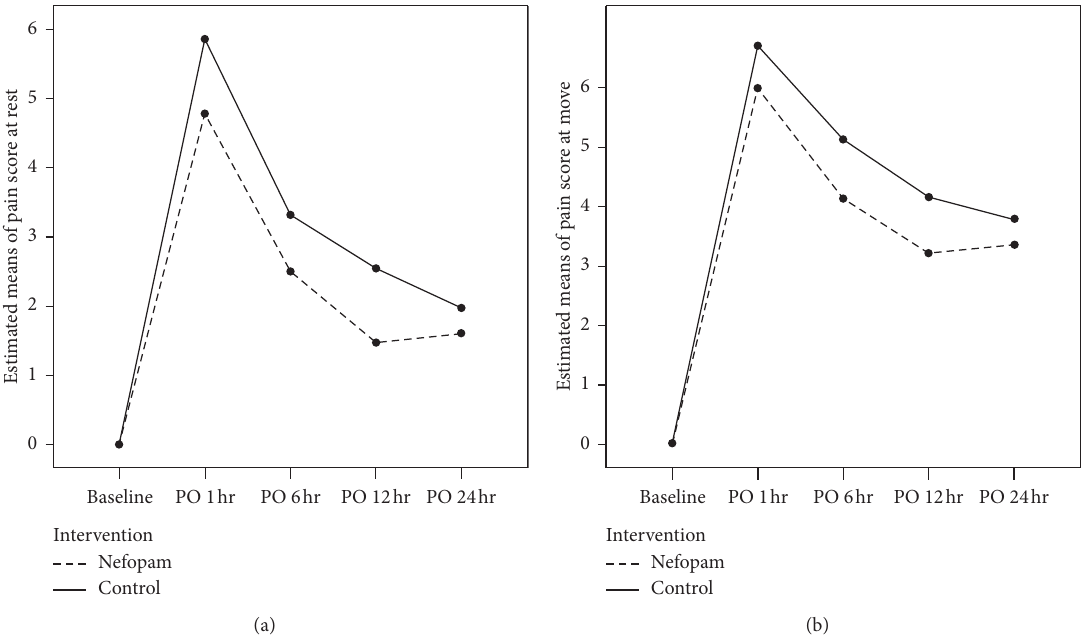
Figure 2: Estimated means of pain score analyzed by mixed-effects regression between nefopam and control at various time points. (a) At rest: no effect of intervention on the estimated mean pain score, P value � 0.058; (b) at movement: intervention, nefopam and control, affecting the estimated pain score, P value � 0.046.